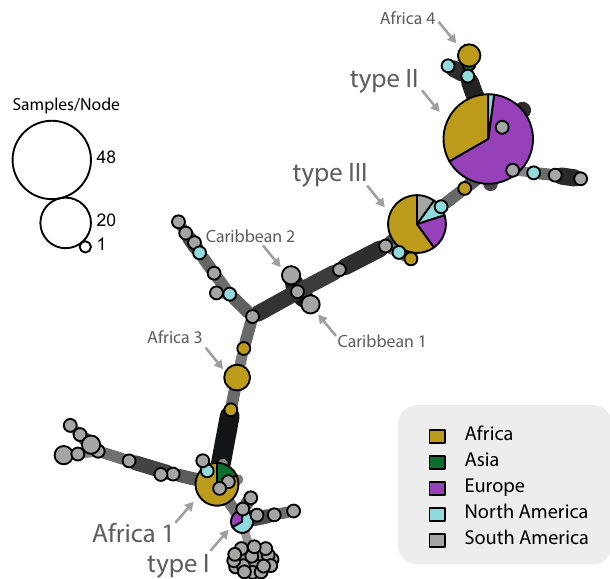
Fig. 2 | Toxoplasma gondii clonal lineages description. Minimum spanning net- work of T. gondii genomes. Genomes separated by a genetic distance less than or equal to 0.01 are collapsed in a single circle and are considered belonging to the same clonal lineage (See Supplementary Note 1). The size of each circle corre- sponds to the number of individuals, and the colours indicate the continent of origin of each individual. Thick and dark lines show MLGs that are more closely related to each other whereas edge length is